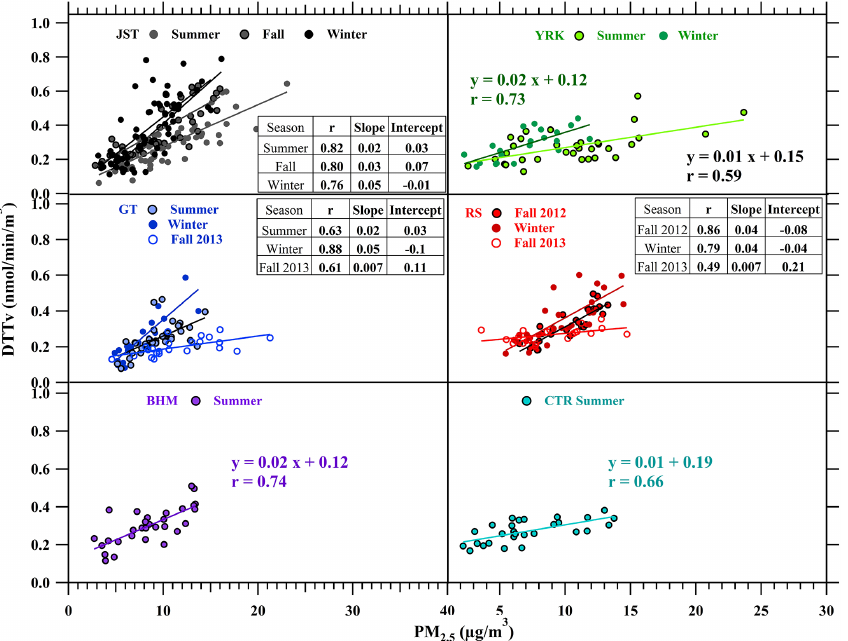
Figure 9. Correlation (Pearson’s r ) between water-soluble DTT activity (DTTv) and PM 2 . 5 mass concentration at JST (urban), YRK (rural), RS (roadside), GT (near-road), CTR (rural), and BHM (urban)